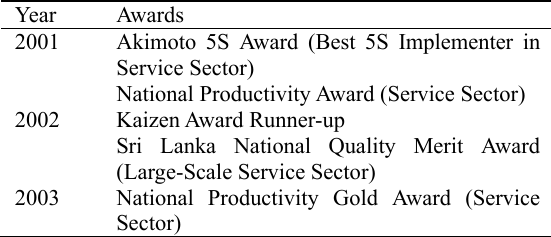
Table 4. Quality awards won by